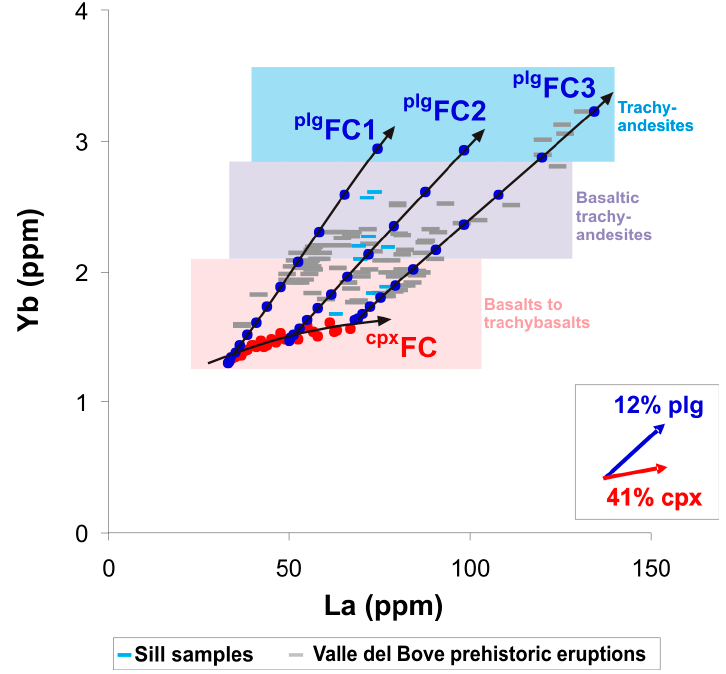
Figure 12. La vs. Yb diagram showing the geochemical evolution of the magma sill in the framework of prehistoric eruptions at Valle del Bove. These data have been modeled through the Rayleigh fractional crystallization equation. At the beginning of the modeling, the early fractionation of clinopyroxene at depth has been considered. Stepwise calculations were performed changing D La and D Yb at each step of fractionation as a function of the geochemical evolution of